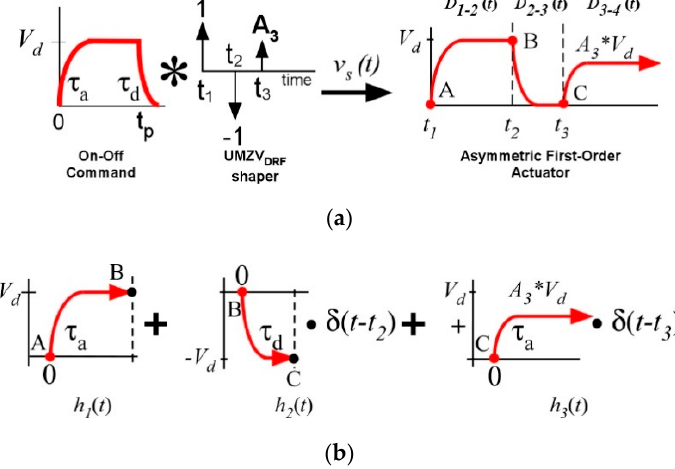
Figure 3. Command separation for start motion. ( a ) Equivalent command process and range division; ( b ) Segmented velocity profiles.